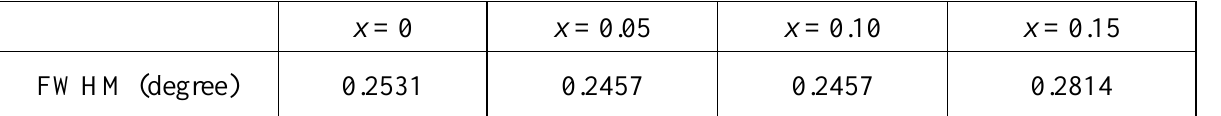
Table 3. The full width at half maximum (FWHM) of the X-ray diffraction peak from